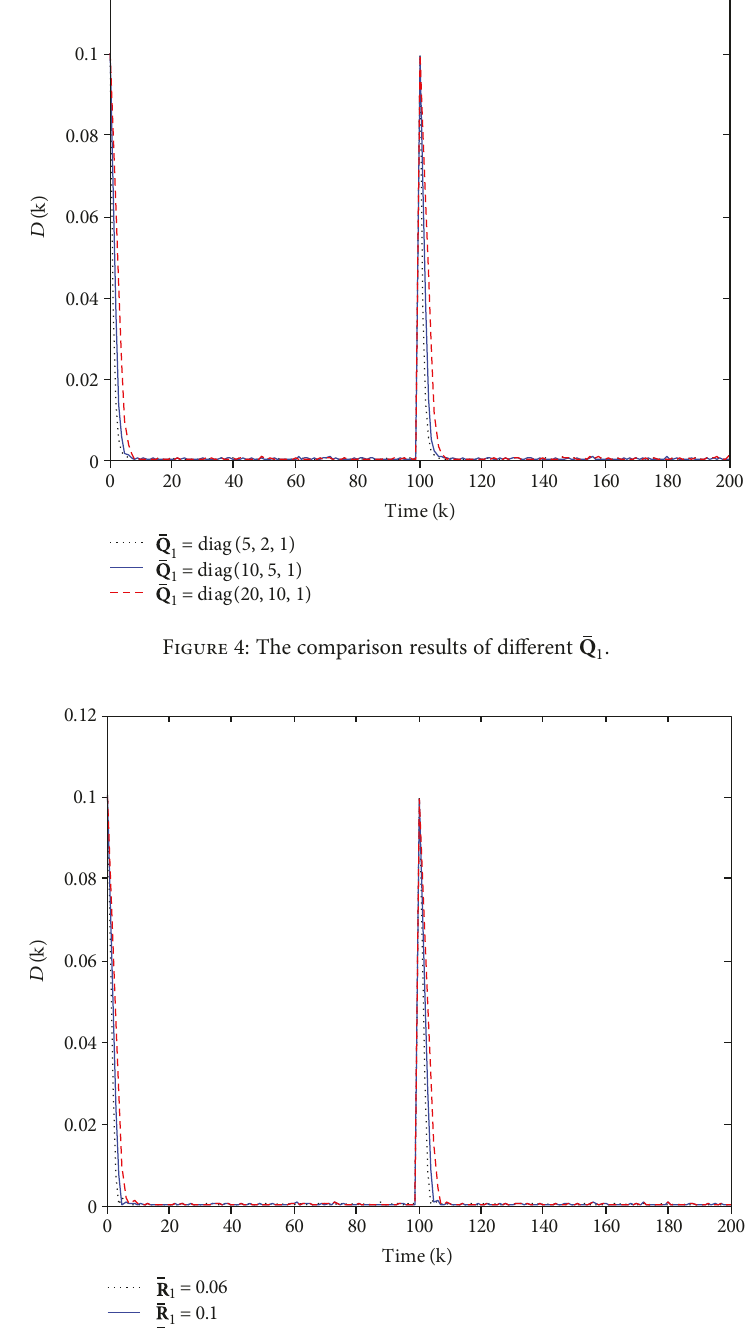
Figure 5: The comparison results of di ff erent R